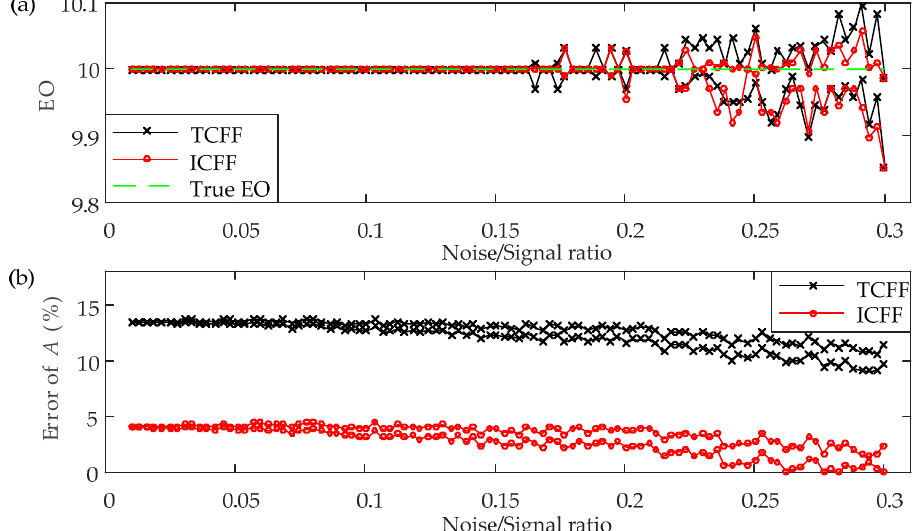
Figure 5. Results of Test 1. ( a ) 95% confidence intervals of the engine order (EO) identification and ( b ) 95% confidence intervals of the relative error of the amplitude identification. • Test 2: